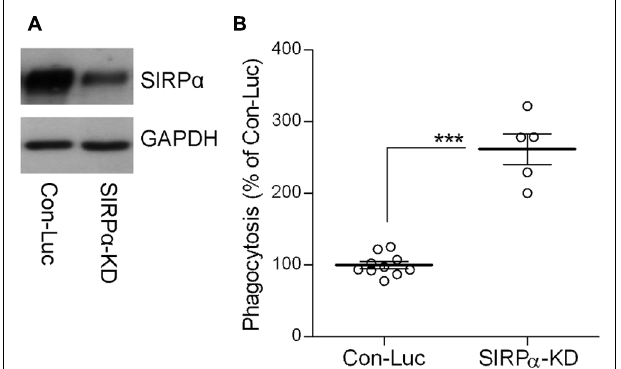
FIGURE 2 |The phagocytosis of degenerated myelin is augmented in SIRP α -KD microglia. (A) A representative (one of three) immunoblot of SIRP α and GAPDH. SIRP α levels are reduced in Balb/C microglia infected with SIRP α -shRNA (SIRP α -KD) compared with control microglia infected with non-target Luciferase-shRNA (Con-Luc). (B) Phagocytosis of degenerated myelin is augmented in SIRP α -KD microglia compared with phagocytosis by control microglia (Con-Luc). Phagocytosis by SIRP α -KD microglia was calculated as a percentage of phagocytosis by control microglia that was defined as 100%.Values of individual experiments each performed in triplicates and averages ± SE are given. Significance of difference by Mann–Whitney is *** p <